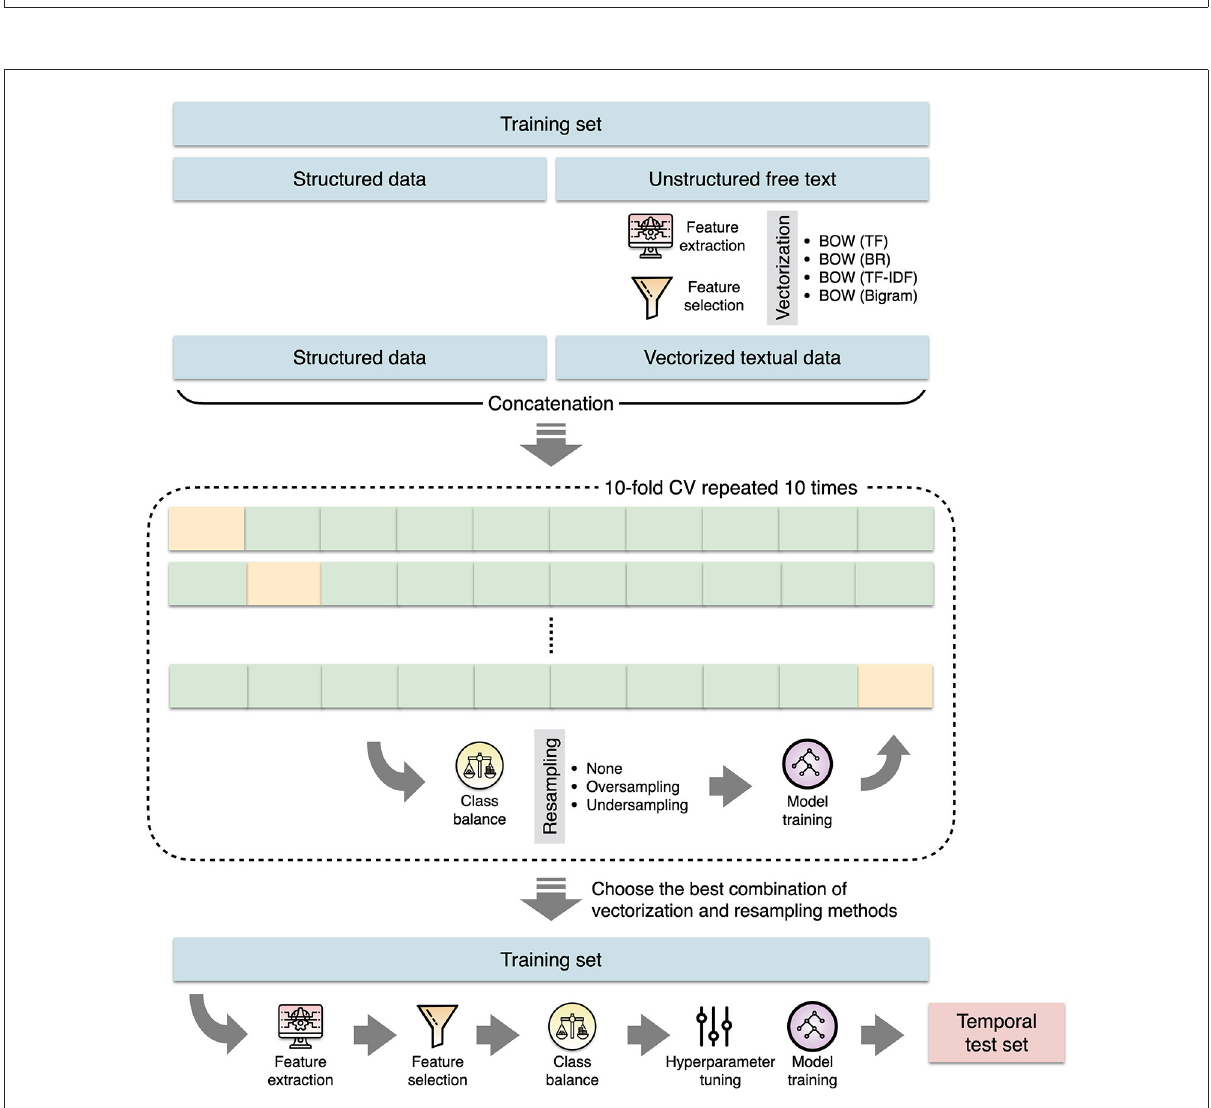
FIGURE2 The process of machine learning model construction. BOW, bag-of-words; BR, binary representation; CV, cross validation; TF, term frequency; TF-IDF, term frequency with inverse document